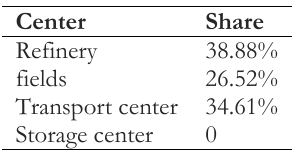
Table 5. The share of each GHG producers.